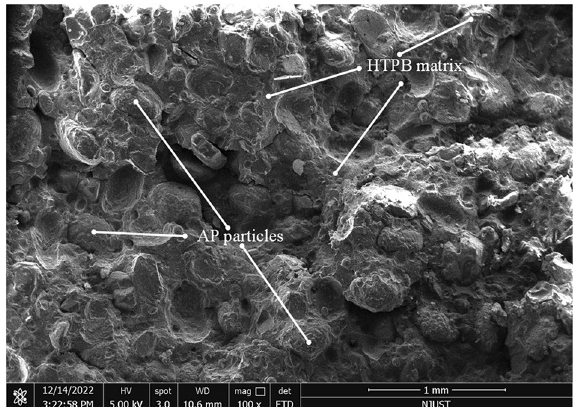
Figure 4. Scanning electron microscope (SEM) image of tested